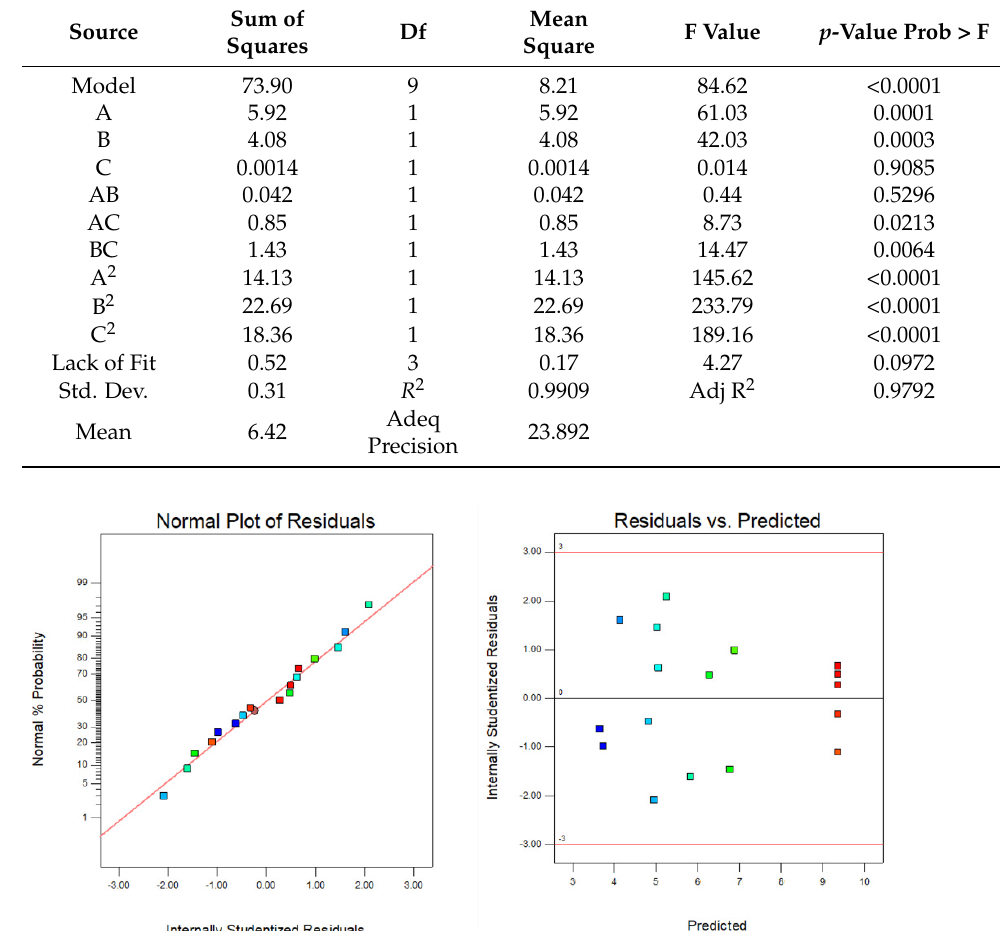
Table 2. Analysis of variance of response surface regression model.